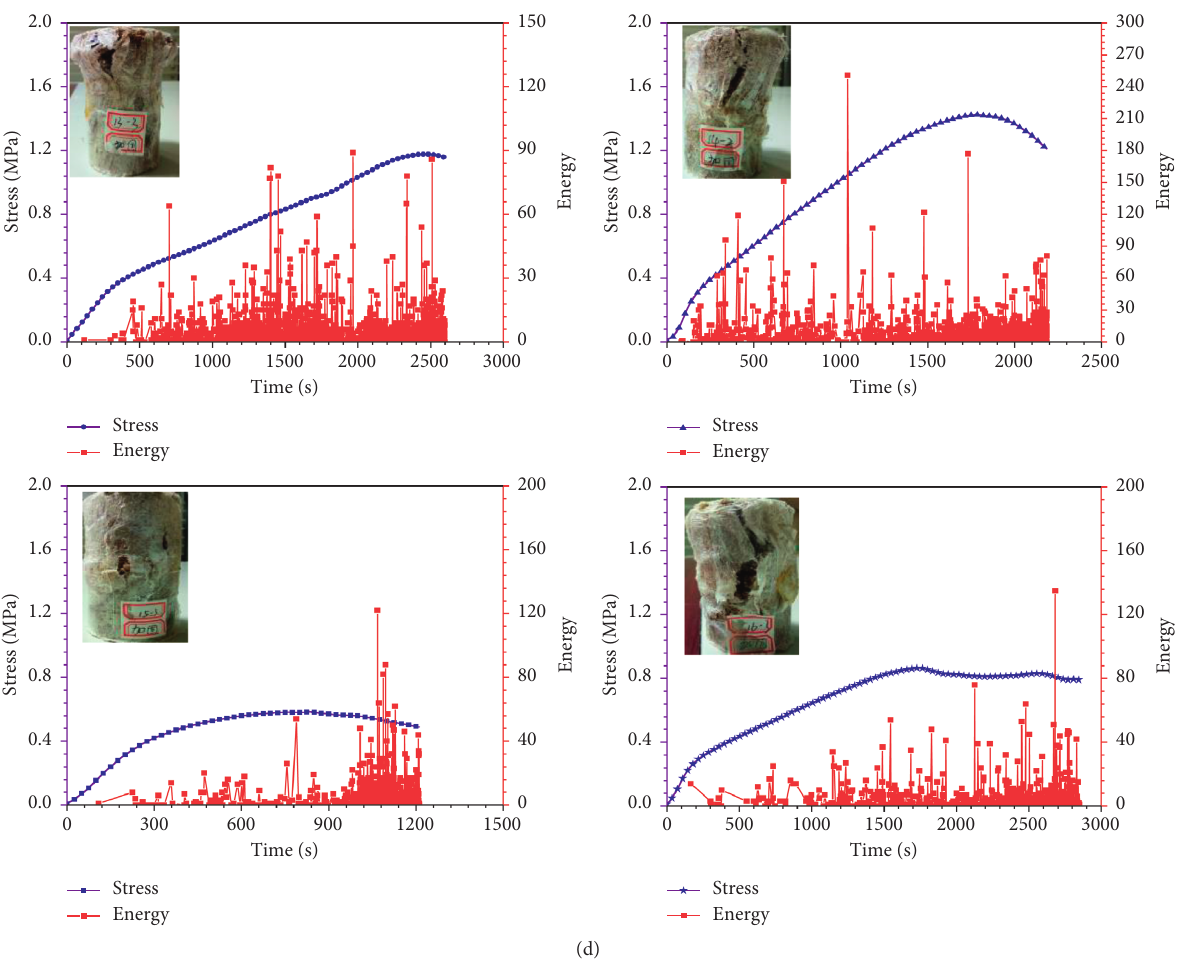
Figure 8: Analysis chart of acoustic emission